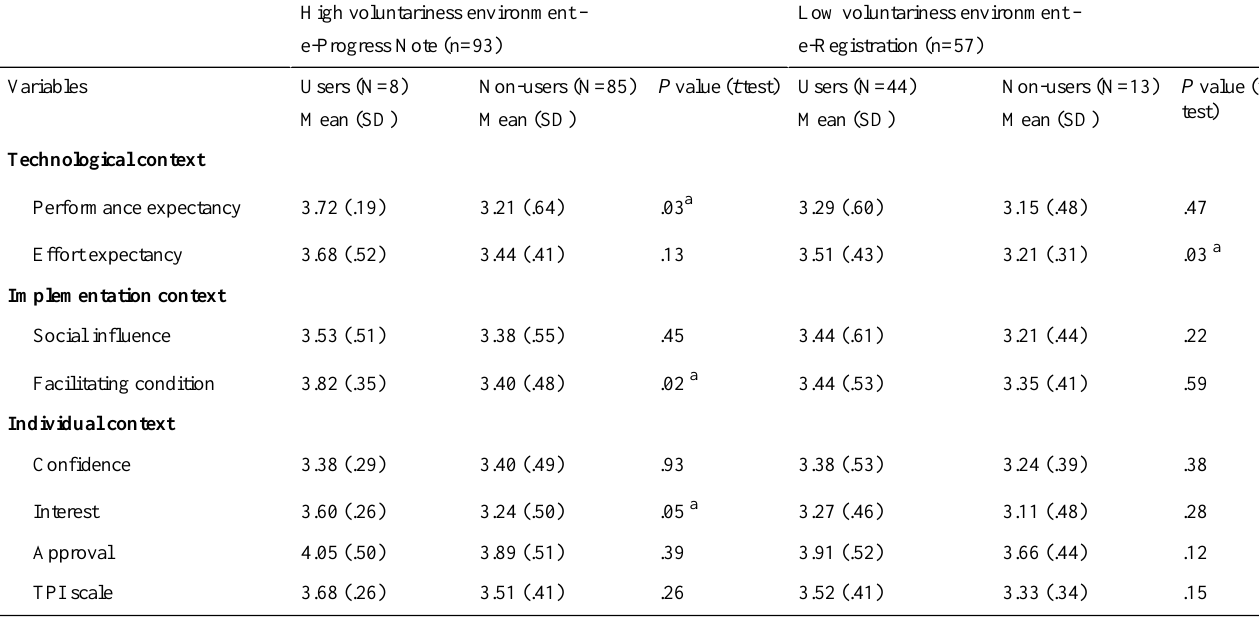
Table 3. Factors associated with actual use in high and low voluntariness environments (n=93).